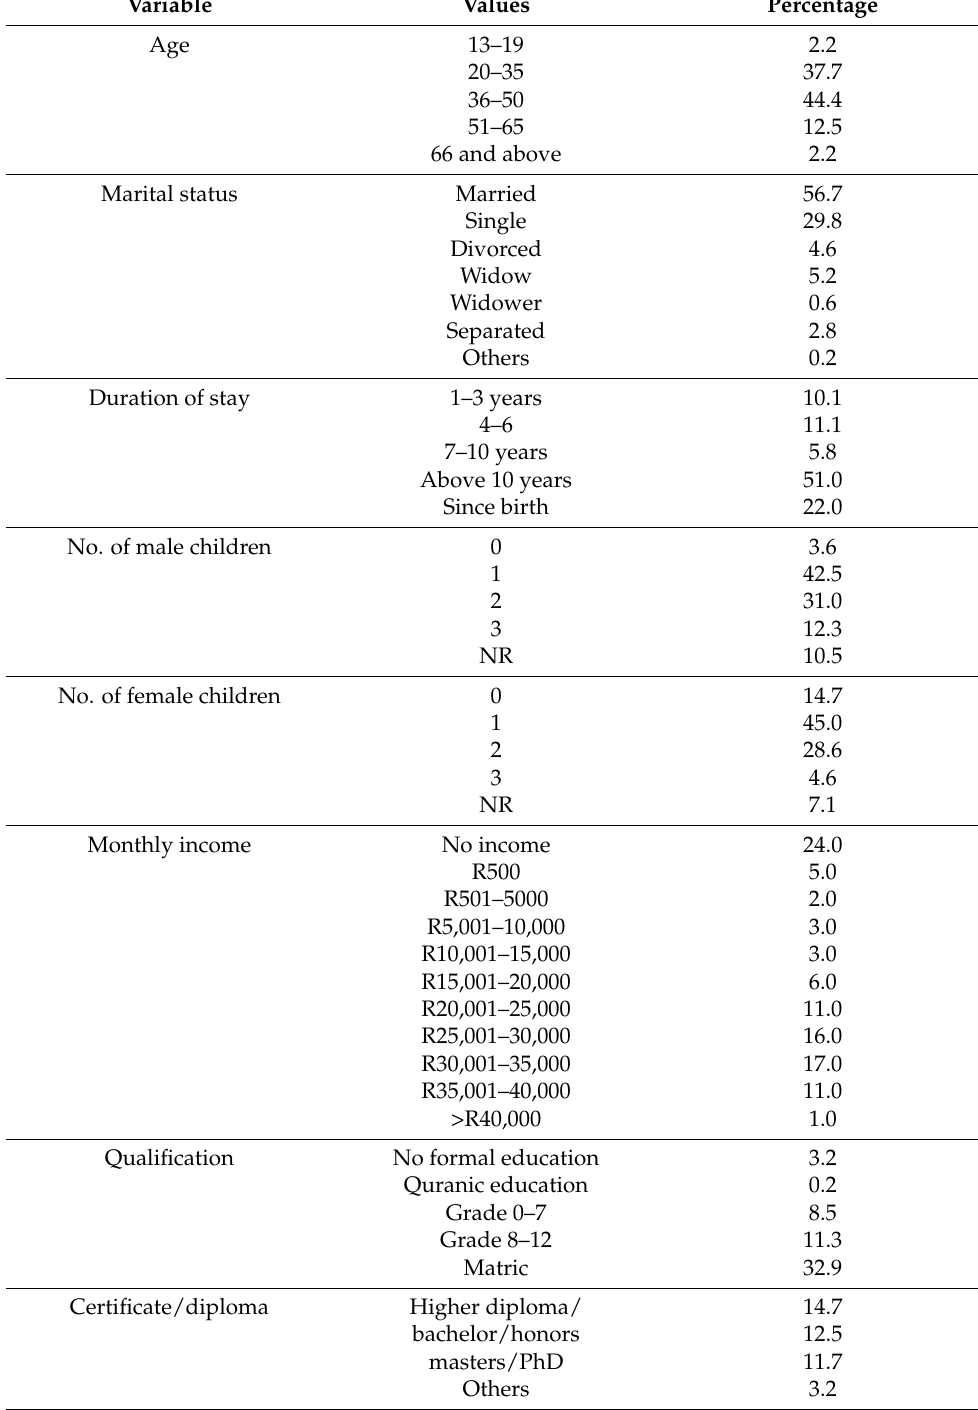
Table 2. Distribution of respondents according to socioeconomic characteristics. * NR: no